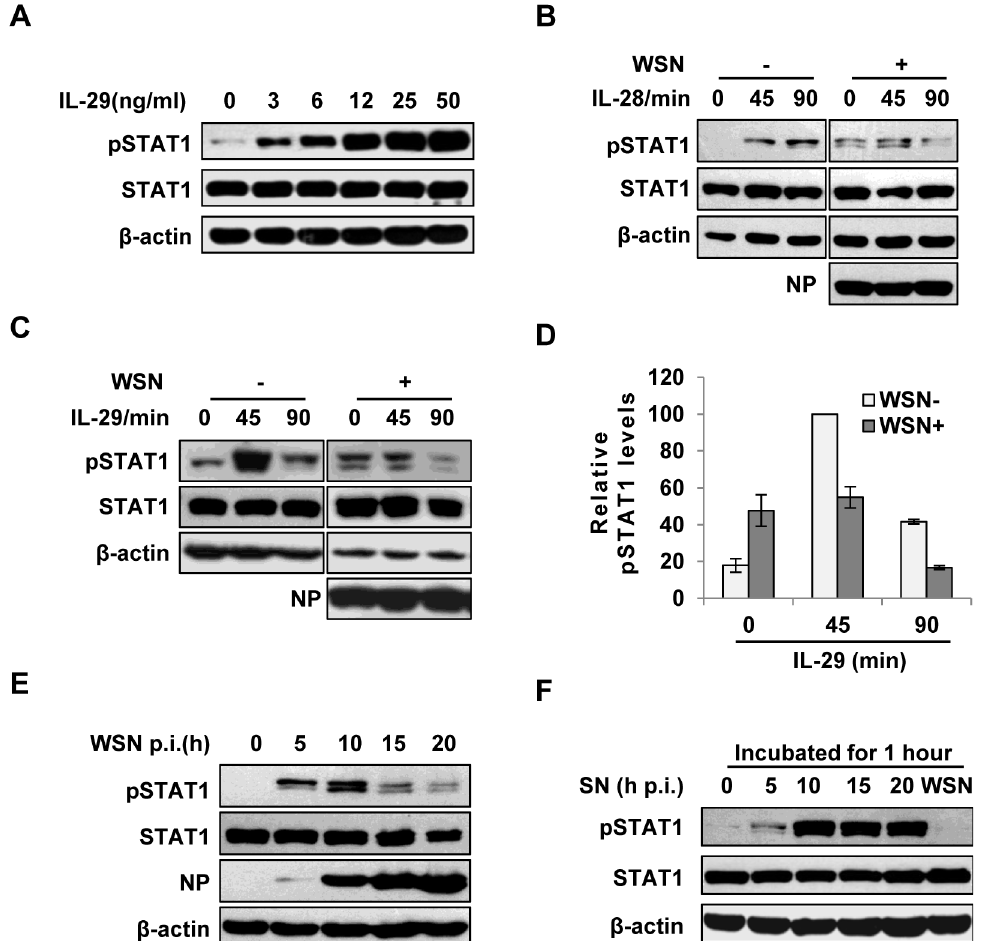
Fig 2. IAV inhibits IL-29-induced STAT1 phosphorylation in A549 cells. (A) A549 cells were treated with IL-29 at final concentration of 3, 6, 12, 25, and 50 ng/ml for 45 min, followed by immunoblotting with indicated antibodies. (B, C) A549 cells infected with WSN (MOI = 1) for 15 h (WSN+) or non-infected (WSN-) were stimulated with human IL-28A (B) or IL-29 (50 ng/ml) (C) for indicated time. Cell lysates were analyzed by Western blotting using indicated antibodies. (D) Levels of phosphorylated STAT1 in (C) were quantitated by densitometry, and normalized to STAT1 expression and control β -actin levels. In each experiment, the highest level of STAT1 phosphorylation is 100. Plotted are the average levels from three independent experiments. The error bars represent the S.E. (E) A549 cells were infected with WSN (MOI = 1), lysed at the 0, 5, 10, 15 and 20 h p.i., and analyzed by Western blotting using indicated antibodies. (F) A549 cells were either stimulated by supernatant (SN) culture medium from IAV-infected cells in (E) or infected with WSN for 1 h, followed by Western blotting with indicated